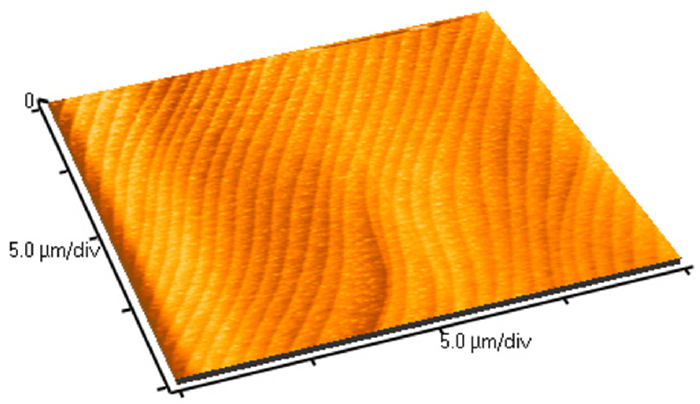
Figure 1. AFM image of LGS crystal surface after one week at 1100 °C under an air atmosphere.